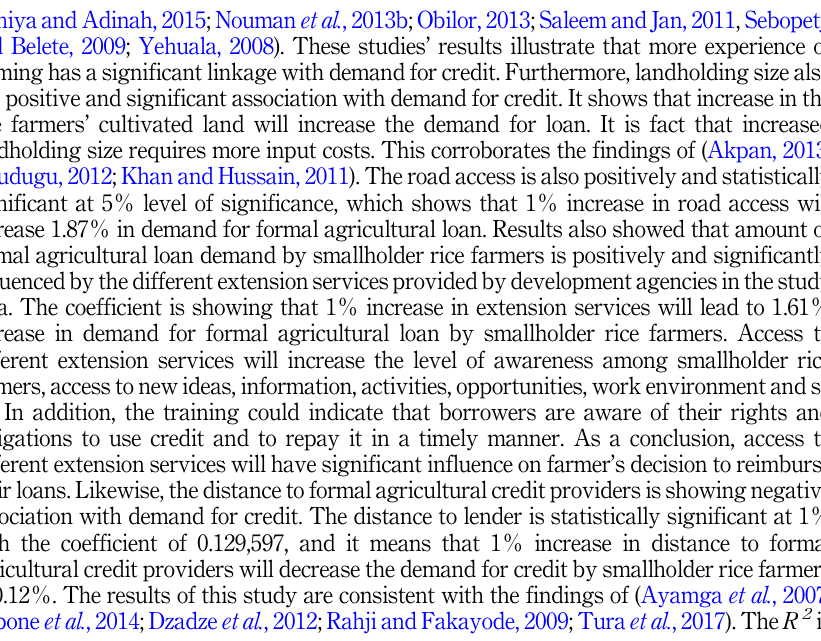
Table 4. OLS results for the determinants of demand for